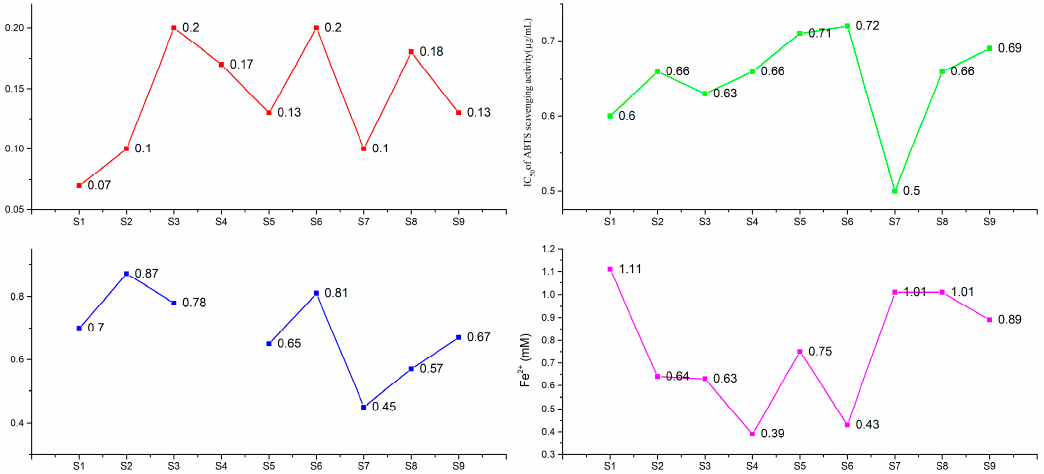
Figure 2. IC 50 (including scavenging activities of DPPH, ABTS, O 2 − ) and reducing force on Fe 3+ of W. japonica.